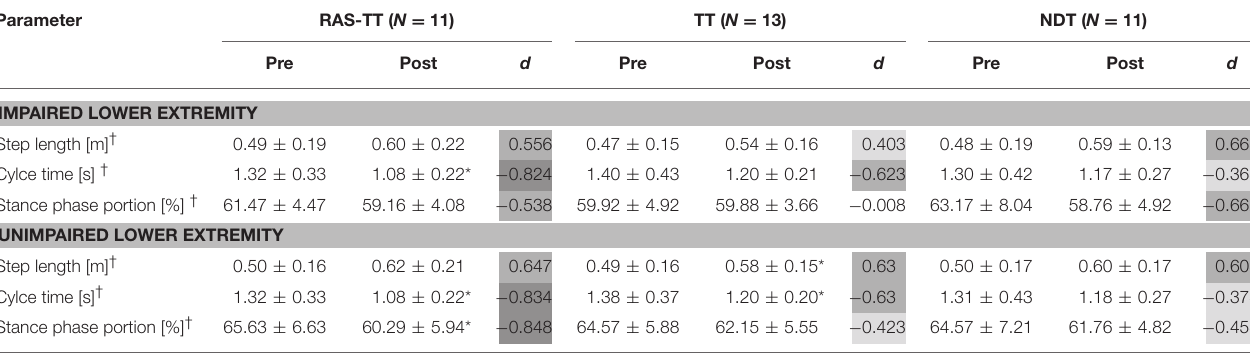
TABLE 3 | Spatial and temporal parameters in pre and post-assessment and effect sizes for the impaired and the unimpaired lower extremity from gait analysis with locometre (means ± standard deviation with 95% confidence interval).